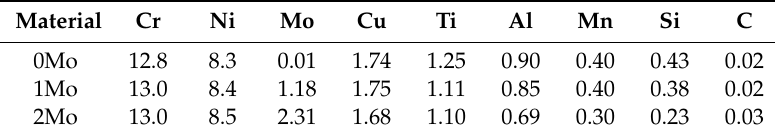
Table 1. Composition of the investigated materials (at.%), with Fe as